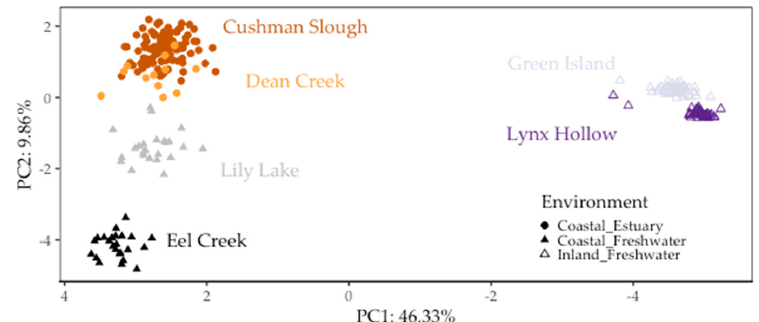
Figure 2. Threespine stickleback population genetic structure partitioned between inland and coastal sites, and between estuary and freshwater sites on the coast. This biplot includes the first two principal component (PC) axes, which accounted for more than half (56.19%) of the overall variation in 391 randomly selected genome-wide SNPs for the six populations in this study [37]. Each point represents a fish. Shape fill represents whether sites were in the Willamette Basin (“Inland”) or in watershed along the coast (“Coastal”). Colors represent collection sites (“populations”) in Oregon. Populations in Oregon based on restriction site-associated DNA sequencing (RAD-seq) single nucleotide polymorphisms